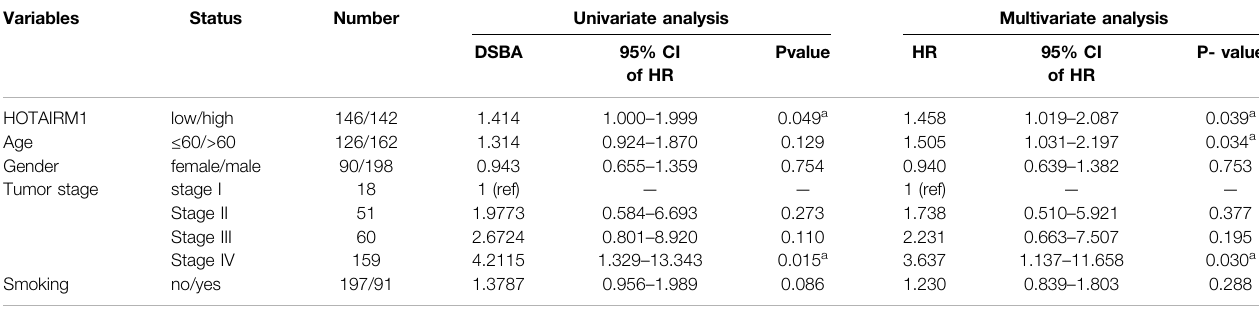
TABLE 1 | Univariate and multivariate Cox regression analyses for overall survival in OSCC patients.